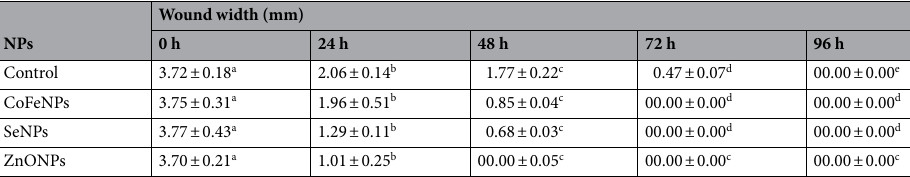
Table 3. Wound healing potential of the myco-fabricated CoFeNPs, SeNPs, and ZnONPs. The calculated mean is for triplicate measurements from two independent experiments ± SD. a–e means with different superscripts in the same row are considered statistically different (LSD test, P ≤ 0.05).